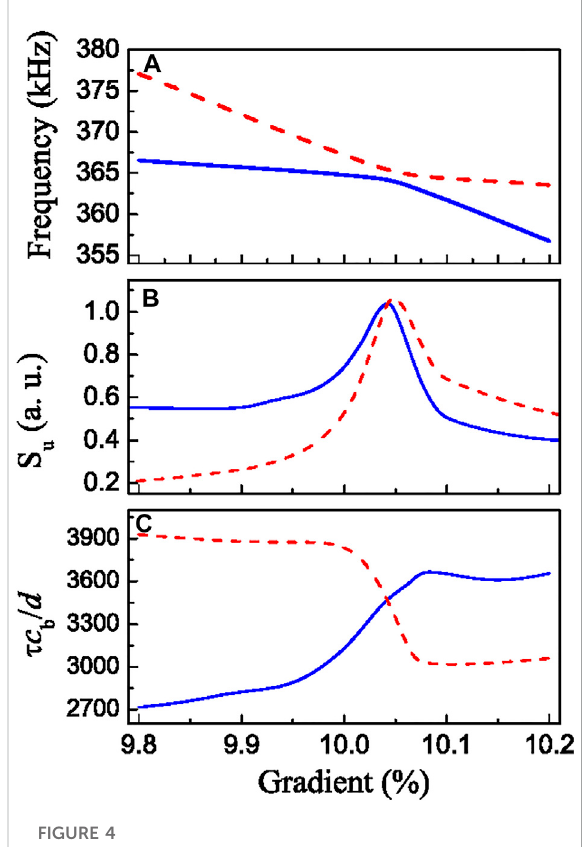
FIGURE 5 Amplitude (in arbitrary units) of the acoustic modes u 1 (blue continuous line) and u 2 (red dashed line) calculated for three values of the thickness gradient. The value 10.04% corresponds to the critical gradient where the avoided crossing occurs. The values of the Shannon entropy are extracted from Figure 4B. The vertical gray bars are guides for eye providing the location of the metamaterial layers (their height is physically